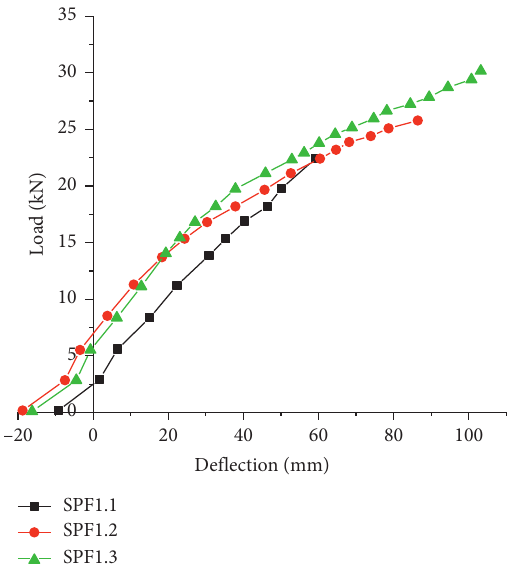
Figure 6: Load-deflection curve of test beams in group A.